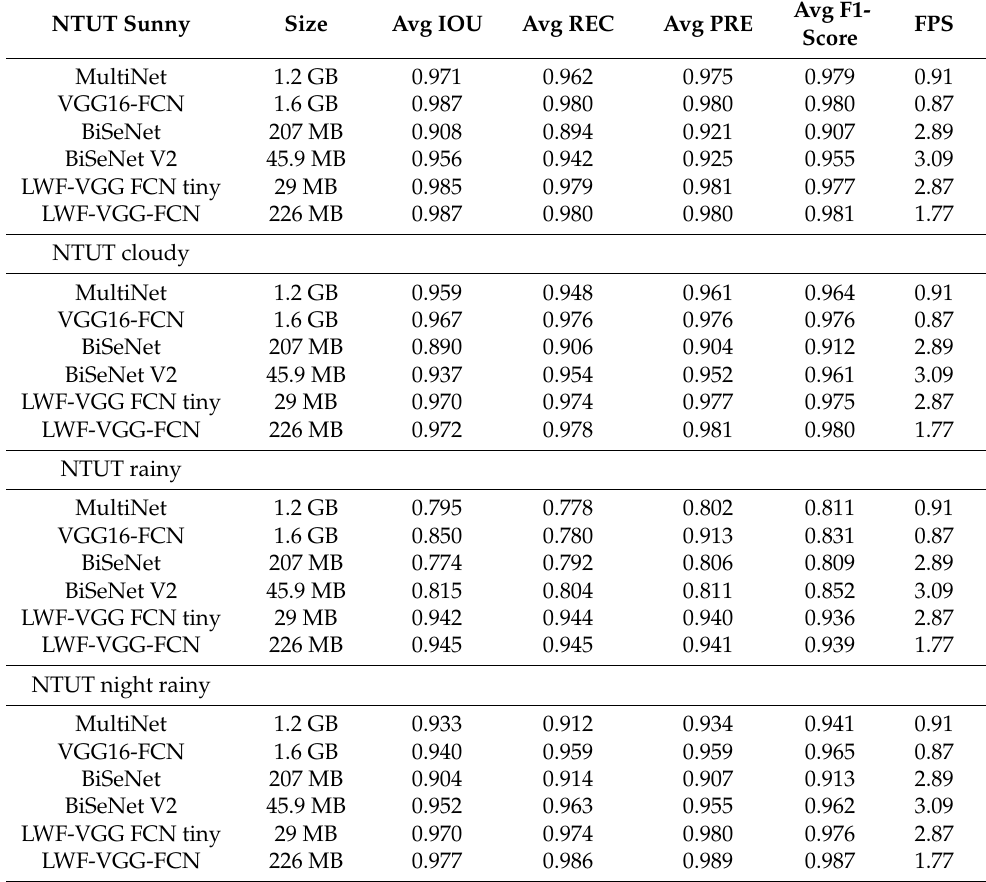
Table 3. Performance of different approaches using the various road datasets. Avg: average; IOU: intersection over union; REC: recall; PRE: precision; FPS: frame per